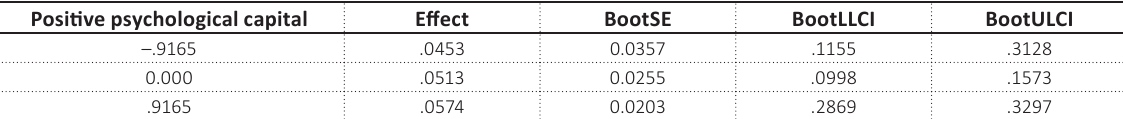
Table 10. Conditional indirect effects